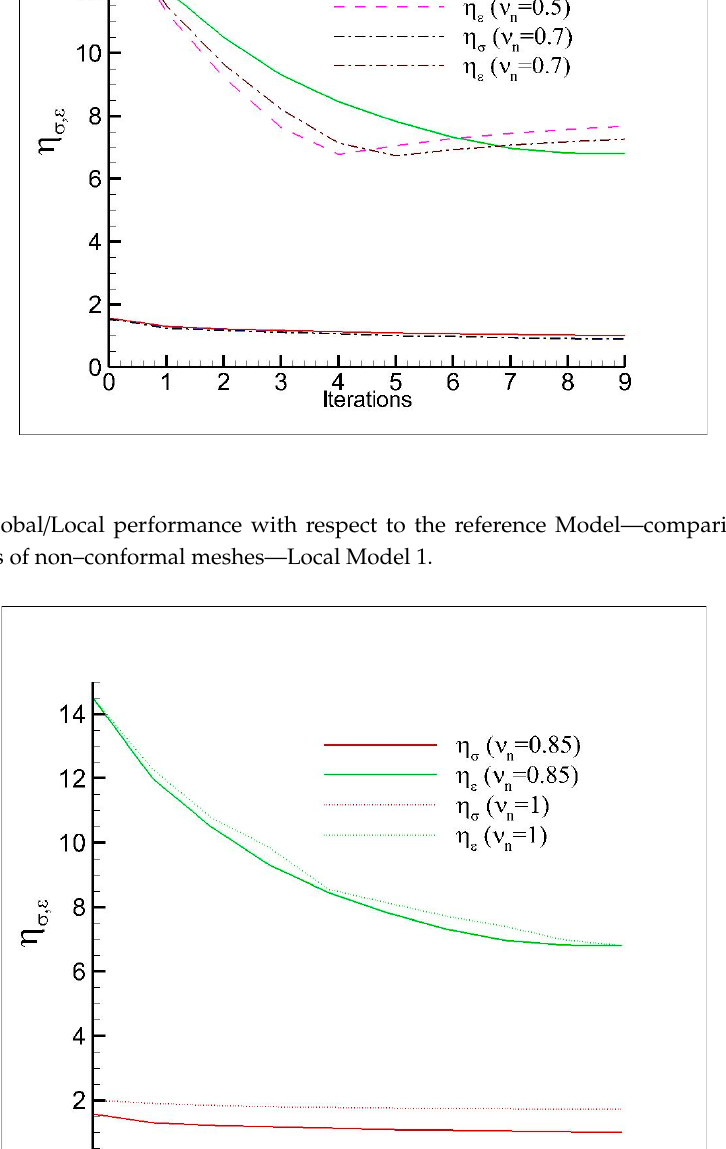
Figure 13. Global/Local performance with respect to the reference Model—conformal mesh and / Local performance with respect to the reference Model—conformal mesh and optimal optimal non–conformal mesh. Figure 13. Global non–conformal